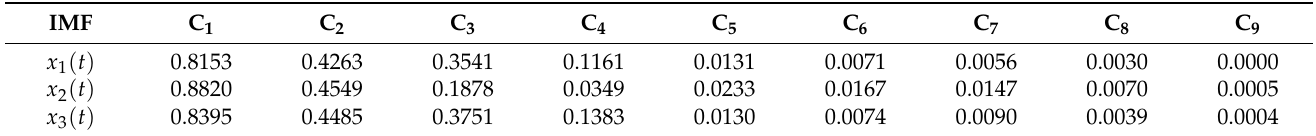
Figure 5. Time–domain waveforms of the linear mixed signals. Table 1. CC values between each IMF and the raw signals.